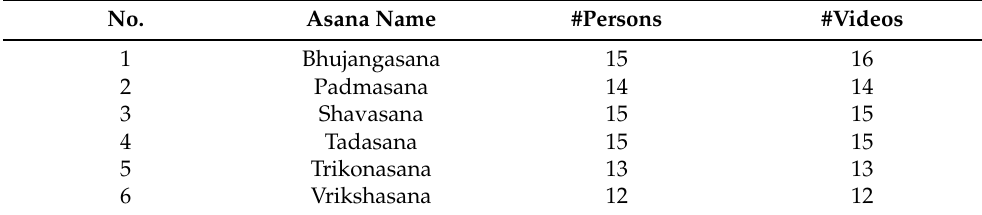
Figure 4. Yoga Poses: ( a ) Bhujangasana, ( b ) Padmasana, ( c ) Shavasana, ( d ) Tadasana, ( e ) Trikonasana, ( f ) Vrikshasana. Table 1.